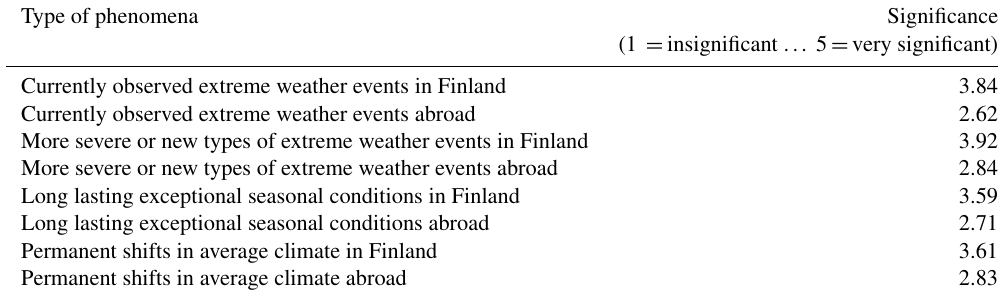
Table 1. Significance of different types of climatic phenomena to the respondent organizations (Appendix A, Question